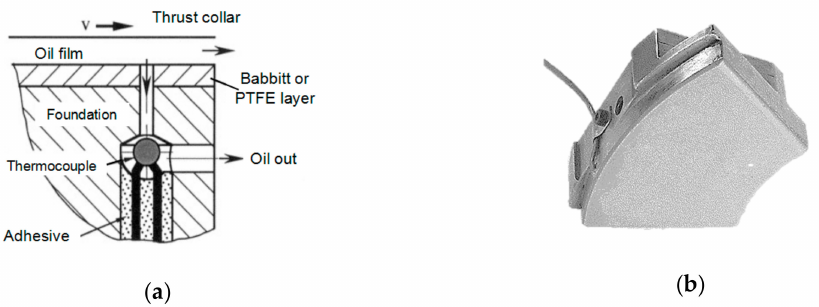
Figure 1. Installation of a thermocouple. ( a ) Installation schematic diagram; ( b ) installation physical